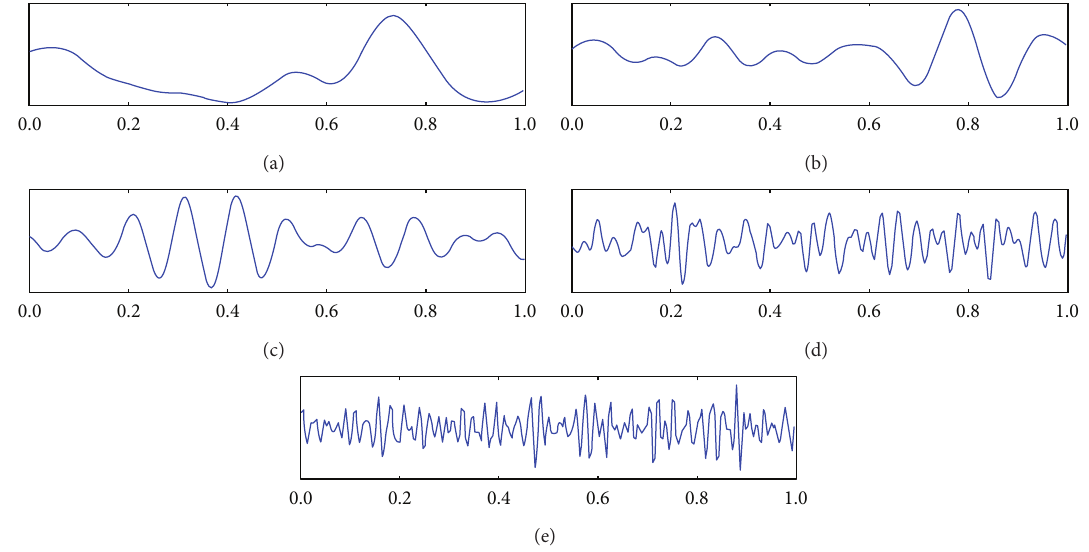
Figure 1: Brainwave: (a) Delta, (b) Theta, (c) Alpha, (d) Beta, and (e) Gamma [9].